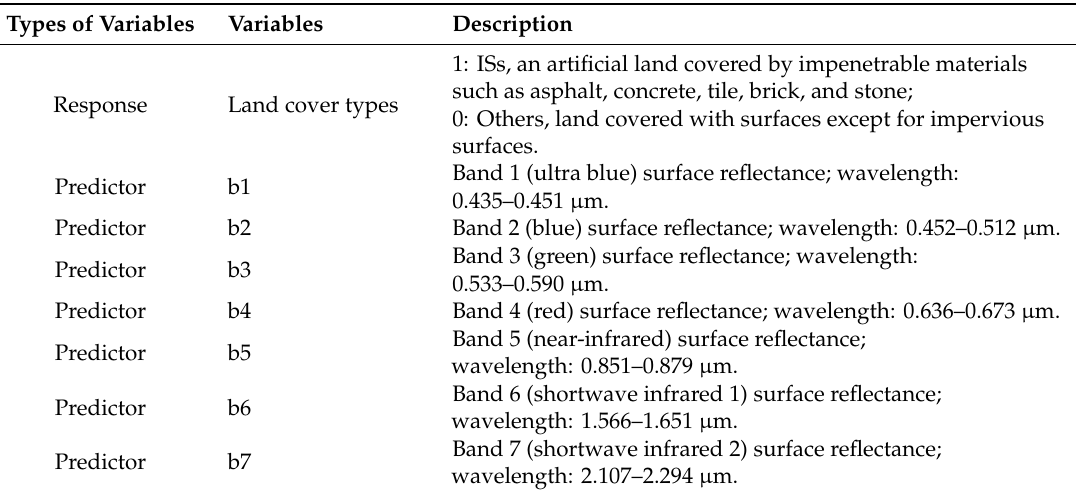
Table 2. Variables used for the random forests (RF)